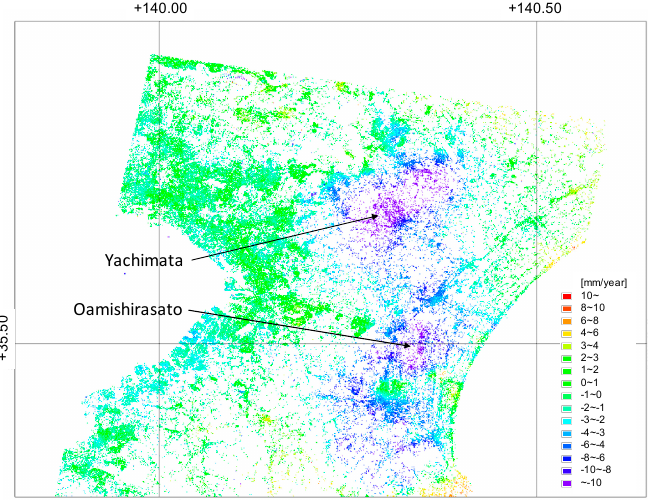
Figure 5. Mean displacement velocity from 2015 to 2019, derived from the PALSAR ‐ 2 data [26]. Some studies have obtained displacement values even for vegetated areas using longer L ‐ band wavelengths [27,28]. However, using PALSAR ‐ 2, vegetated areas could not be observed due to lower coherence. Further, PALSAR ‐ 2 operates by acquiring data on fewer points than that acquired by PALSAR. A reason for this could be the larger RMSE of each time ‐ series displacement value in the PALSAR ‐ 2 dataset (Section 4.2). Further analysis is required to understand the pertinent